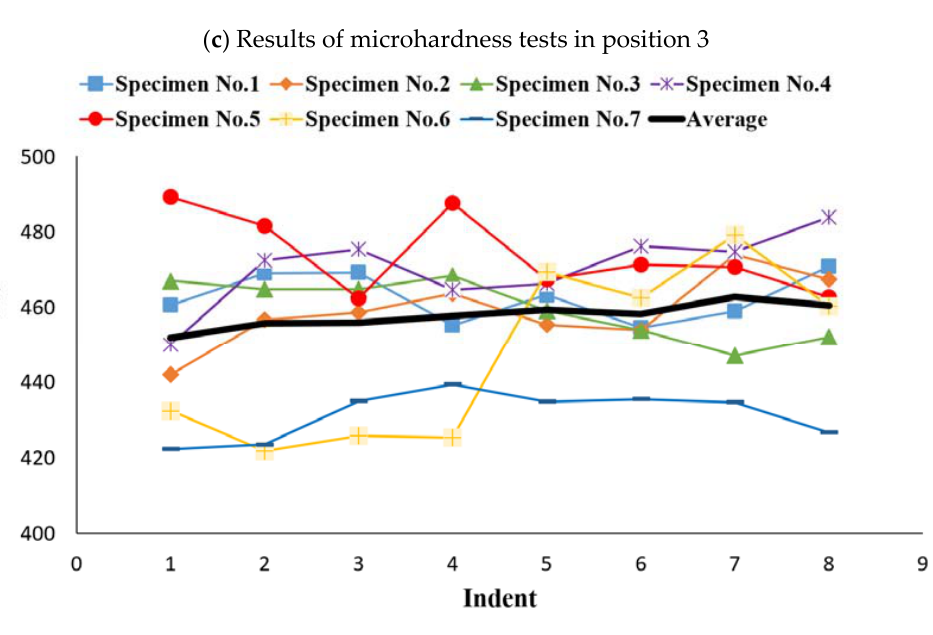
Figure 21. Microhardness graphs on different positions, including ( a ) position 1, ( b ) position 2, ( c ) position 3, and ( d ) position 4.